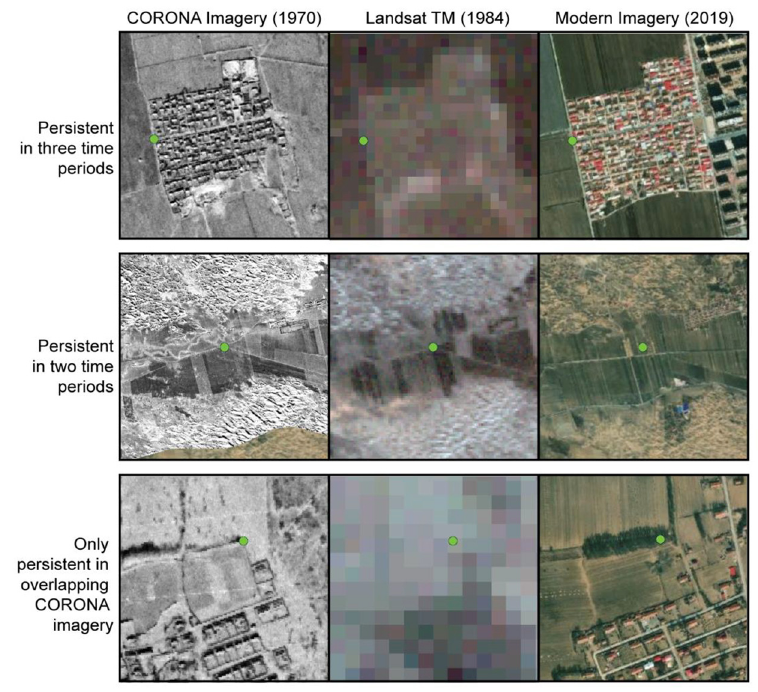
Figure 4. Examples ground control points (green dots) overlaid on Corona imagery and two separate reference